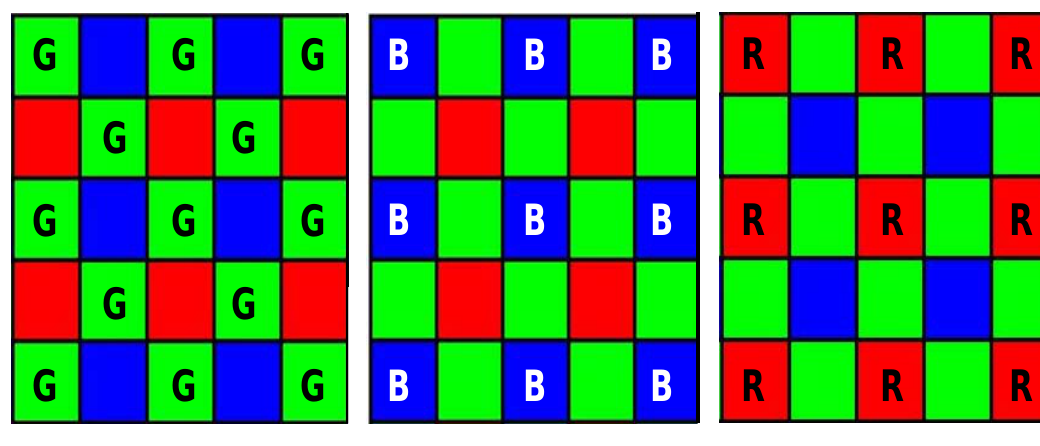
Figure 4. Filter Masks for Bayer Pattern